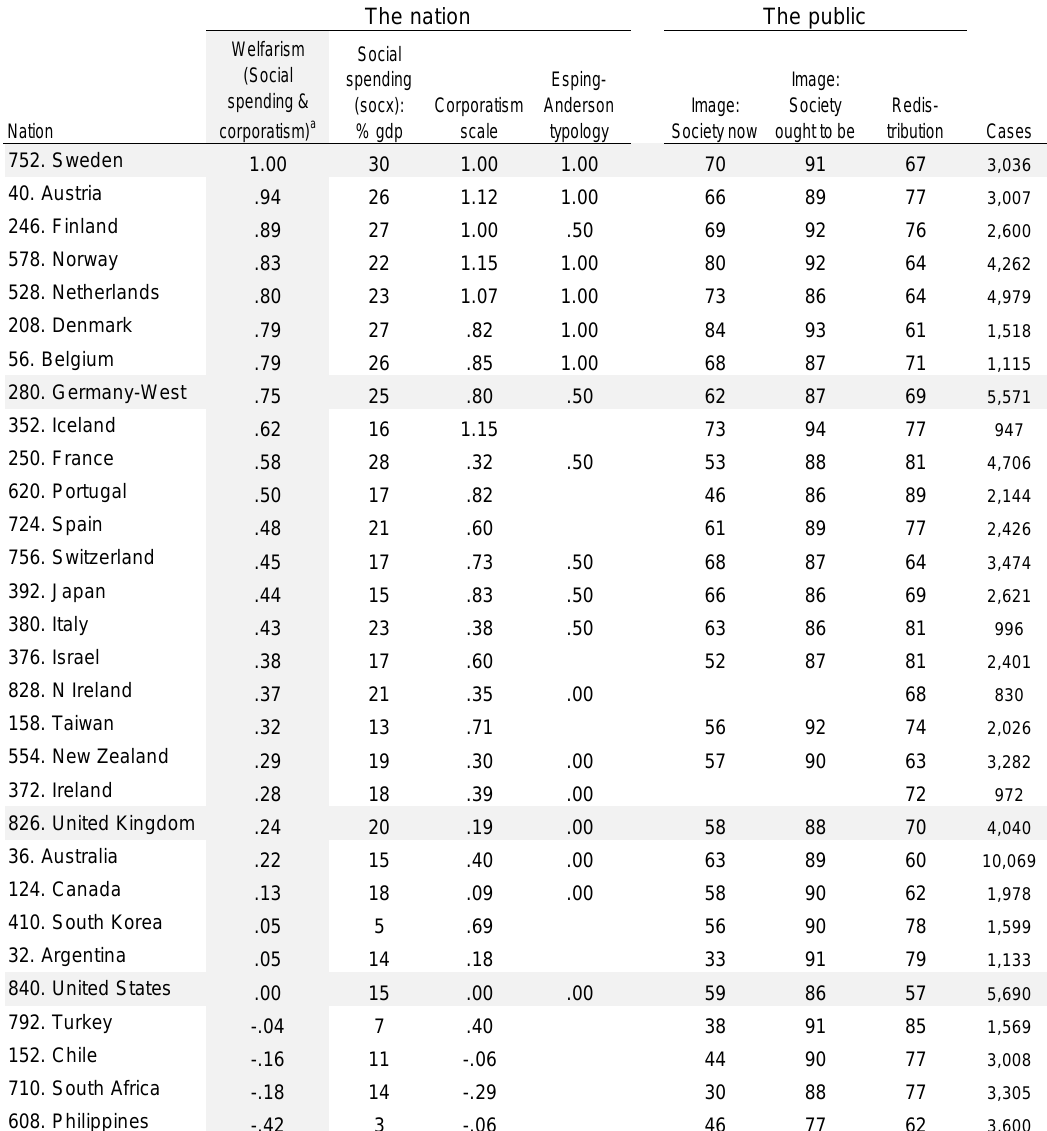
Figure 1. The welfare state and its public. Description. 30 never-Communist societies, 71 surveys, 1987–2009, with 88,904 individual